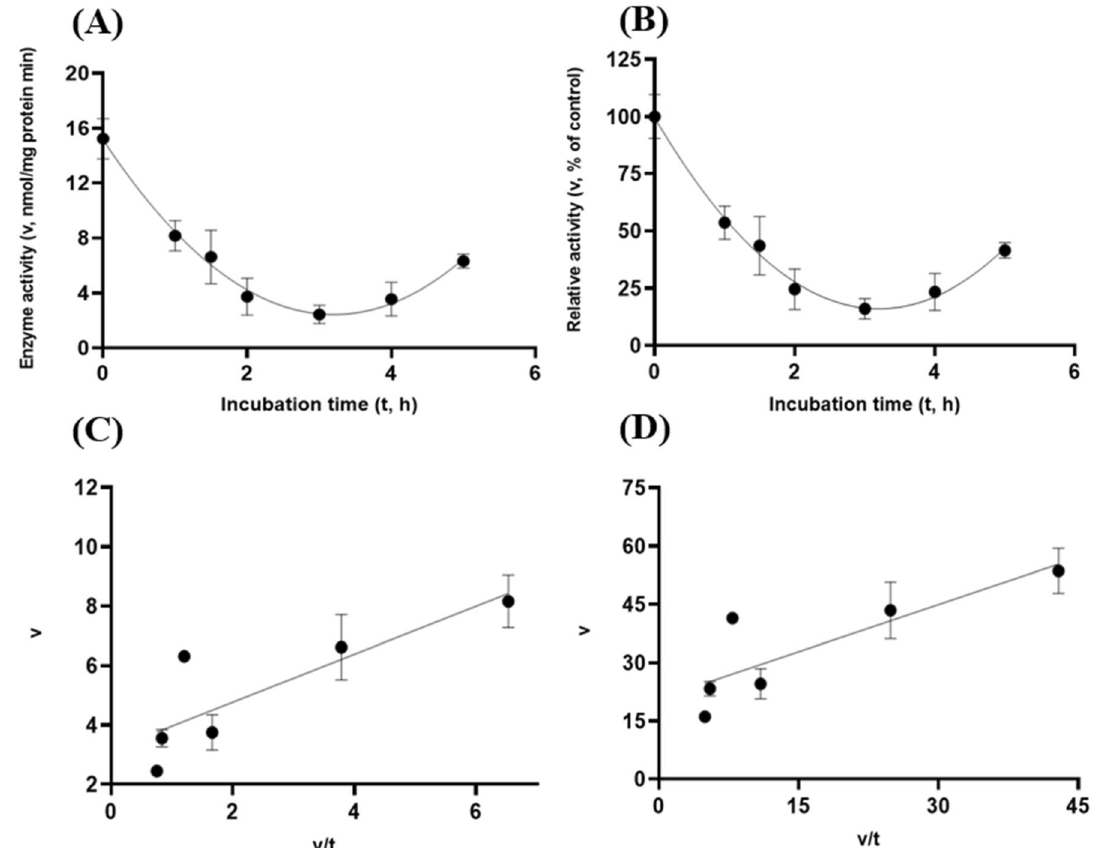
Figure 13. Experiment-3 of the intestinal pancreatic trypsin (78 U/mL) effects (with describing model parameter estimates ± SE ) on heat-treated GH5-tCel5A1 activity over a 5-h period after the intestinal pancreatic trypsin buffer being mixed with the heat-treated GH5-tCel5A1 enzyme preparation for incubation at the resulting mixture pH = 6.0–7.0 and trypsin (78 U/mL) prior to further incubation for measuring cellulase activity with the carboxymethyl cellulose (CMC) substrate buffer in presence of dithiothreitol (DTT) (5 mM) and N 2 gas purging for 15 min at 37 °C. (A) Plot of the inhibition kinetic relationship between the heat-treated GH5-tCel5A1 activity (v, mean ± SE, n = 12at each time point, nmol/mg protein•min) and incubation time (t, h) under the trypsin (78 U/mL) condition established according to the quadratic response model as: Y = 17.408 ( ± 1.388 ) − 8.694 ( ± 1.154 ) x + 1.259 ( ± 0.198 ) x 2 , P < 0.0001 for all parameter estimates; R 2 = 0.475 , n = 84; and alternatively according to the linear response model established as y = 10.718 ( ± 1.103 ) − 1.599 ( ± 0.357 ) x , P < 0.0001 for all parameter estimates, r 2 = 0.209 , n = 84; (B) Quadratic plot of the inhibition kinetic relationship between the relationship of relative heat-treated GH5-tCel5A1 activity (v, mean ± SE, n = 12at each time point, % of the control group measured at I c of 100.000 ± 9.682) at 0-min exposure to the trypsin-78-U/mL incubation) and incubation time trypsin (78 U/mL) conditions established according to the quadratic response model as: Y = 114.3 ( ± 9.116 ) − 57.093 ( ± 7.581 ) x + 8.273 ( ± 1.302 ) x 2 , P < 0.0001 for all parameter estimates, R 2 = 0.475 , n = 84; and alternatively established according to the linear response model as y = 70.388 ( ± 7.242 ) − 10.502 ( ± 2.346 ) x , P < 0.0001 for all parameter estimates, r 2 = 0.210 , n = 84; (C ) the Eadie-Hofstee linear plot between the heat-treated GH5-tCel5A1 enzyme activity (v, mean ± SE, n = 12at each data point, nmol/mg protein•min) and the v/t ratio established as y = 1.918 ( ± 0.353 ) + 1.322 ( ± 0.092 ) x , P < 0.0001 for all parameter estimates; r 2 = 0.749 , n = 72; and (D ) the Eadie-Hofstee linear plot between the relative heat-treated GH5-tCel5A1 enzyme activity (v, mean ± SE, n = 12at each data point, % of the control group measured at I c of 100.000 ± 9.682) at 0-min exposure to the trypsin-78-U/mL incubation) and the v/t ratio established as y = 12.602 ( ± 2.321 ) + 1.322 ( ± 0.092 ) x , P < 0.0001 for all parameter estimates; r 2 = 0.749 , n =